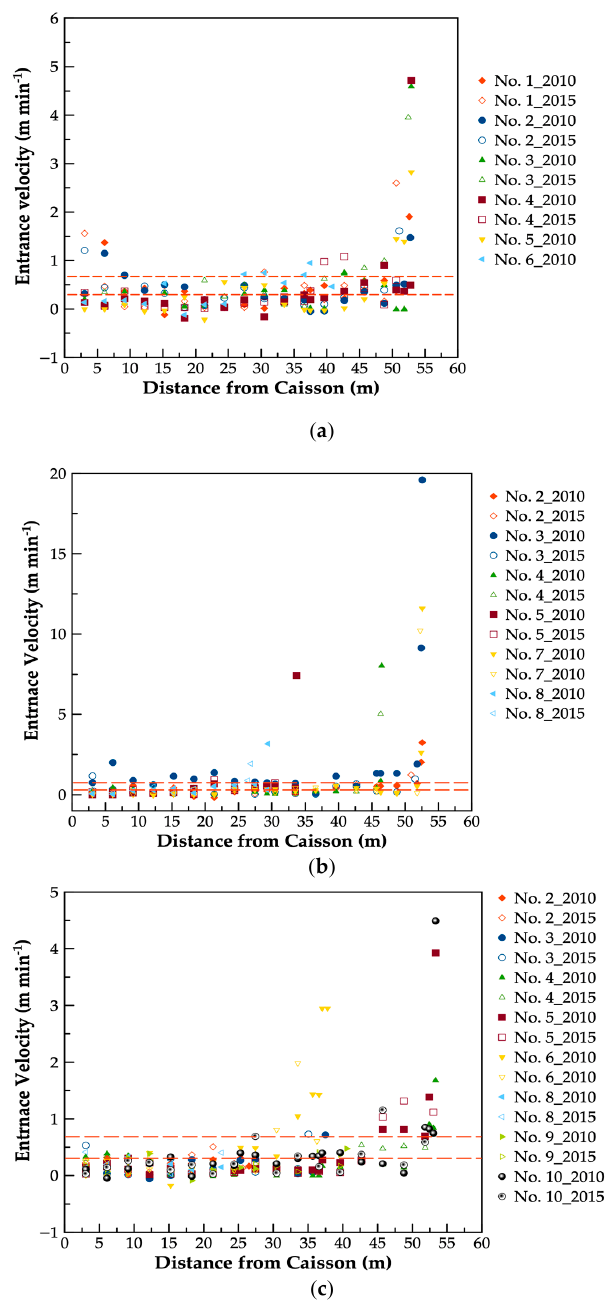
Figure 7. Entrance velocity through different laterals with increasing distances for their ends for ( a ) Collector 3, ( b ) Collector 4, and ( c ) Collector 5. Ideal and optimal design < 0.305 and < 0.610 m min − 1 (bottom and top red